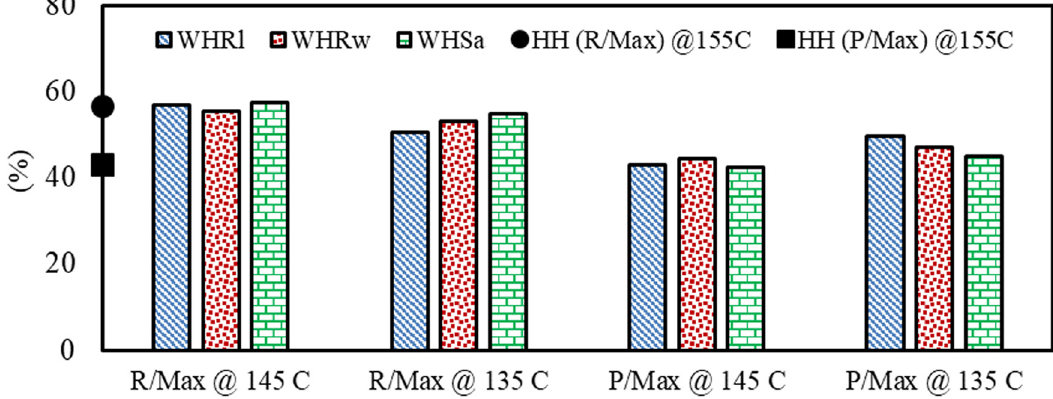
Figure 15: Final percentages of recovered and permanent strain at the termination of the second cycle of